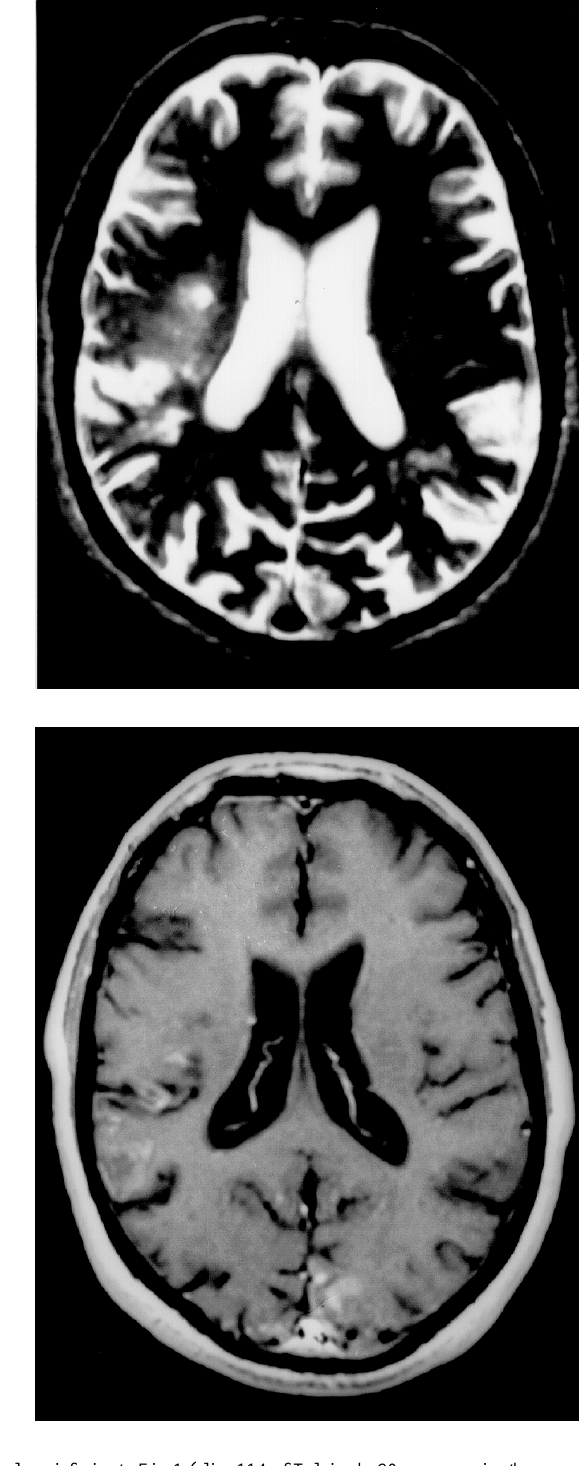
Fig. 2. Similar images as Fig.1 plus T2-weighted images top right, 1 plane inferior to Fig.1 (slice 114 of Talairach, 20mm superior the ac-pc line). The MRI show a left occipital (No.2) and a right insular (No.3)